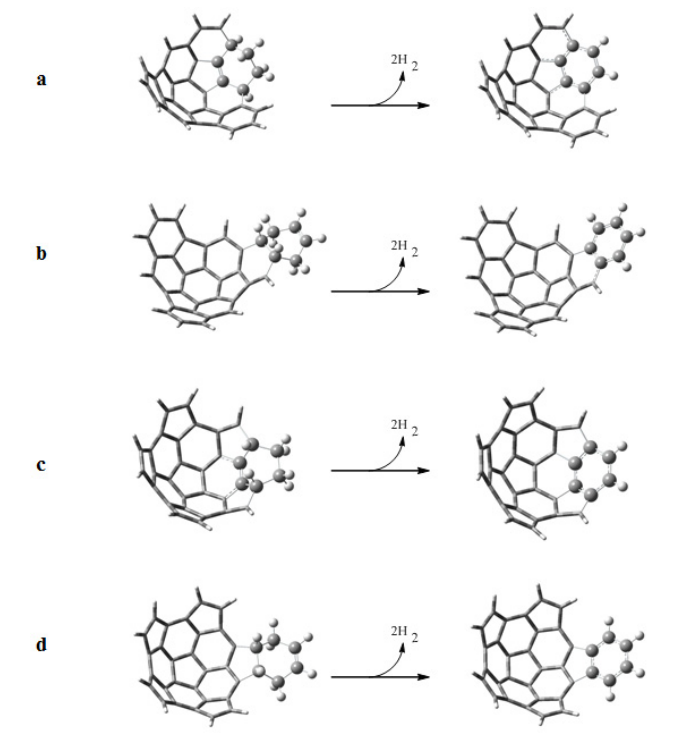
Figure 7. Dehydrogenation reactions to aromatize the adducts obtained from